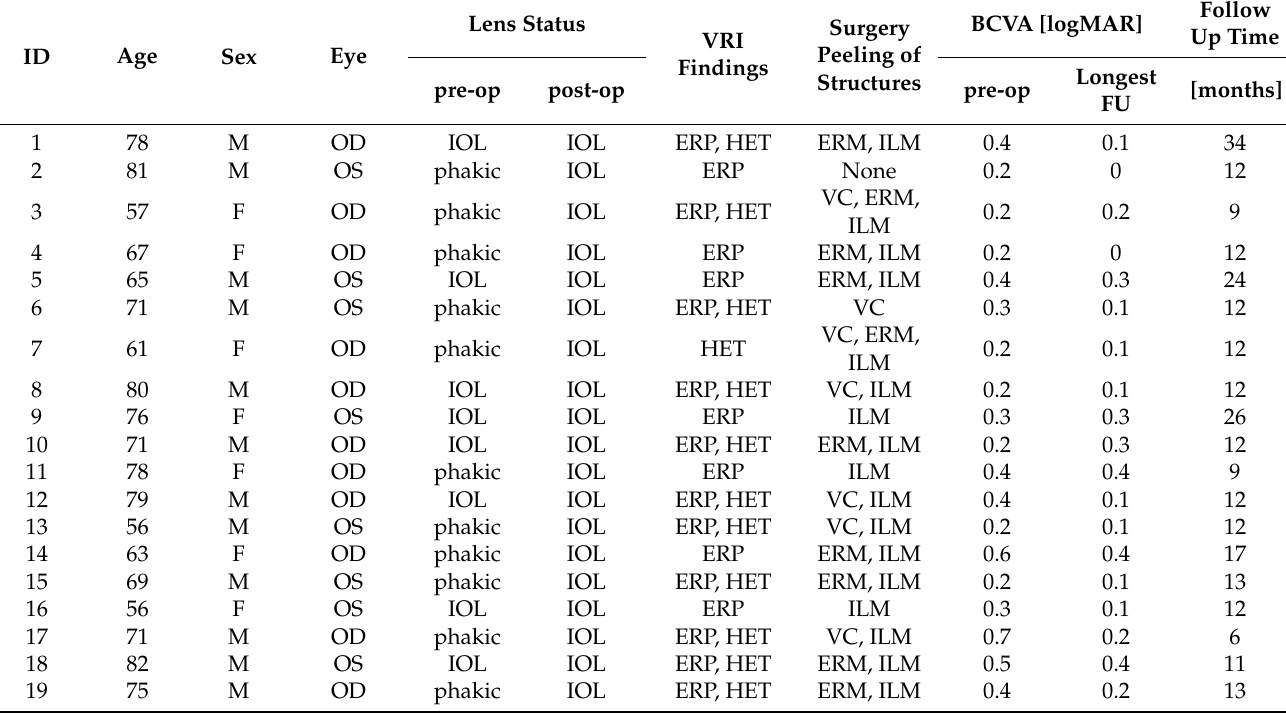
Table 1. Clinical and surgical data. M, male; F, female; OD, right eye; OS, left eye; IOL, intraocular lens; EP, epiretinal proliferation; HET, hyperreflective epiretinal tissue; ERM, epiretinal membrane; ILM, internal limiting membrane; VC, vitreous cortex; BCVA, best-corrected visual acuity; FU, follow-up.